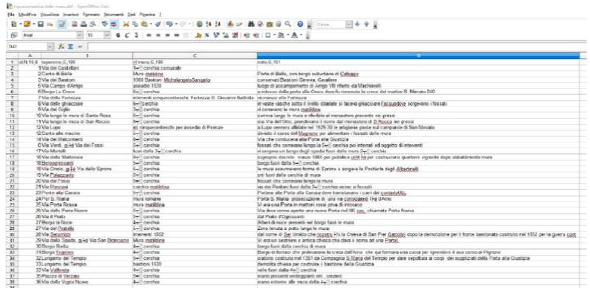
Figure 14. Textual filling of the attribute